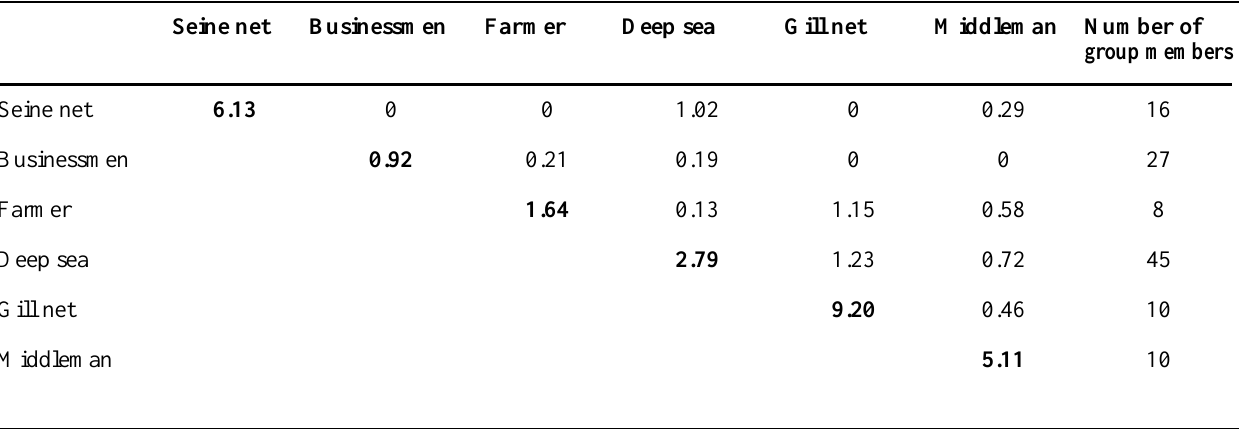
Table 3. Occupational group sociomatrix based on information/knowledge exchange network (Table 1). Numbers in cells represent the ratio of the measured vs. the expected number of relational ties. Seine